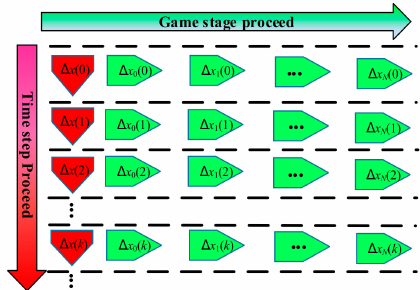
Figure 5. The detailed process of game